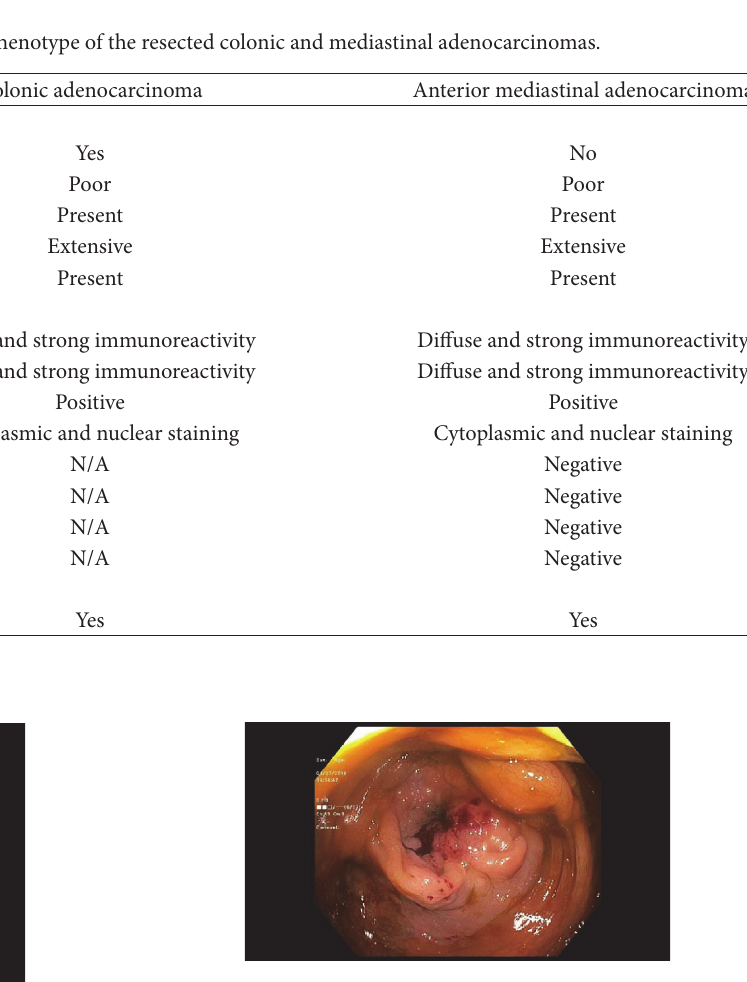
Figure 2: Colonoscopic image of the cecal